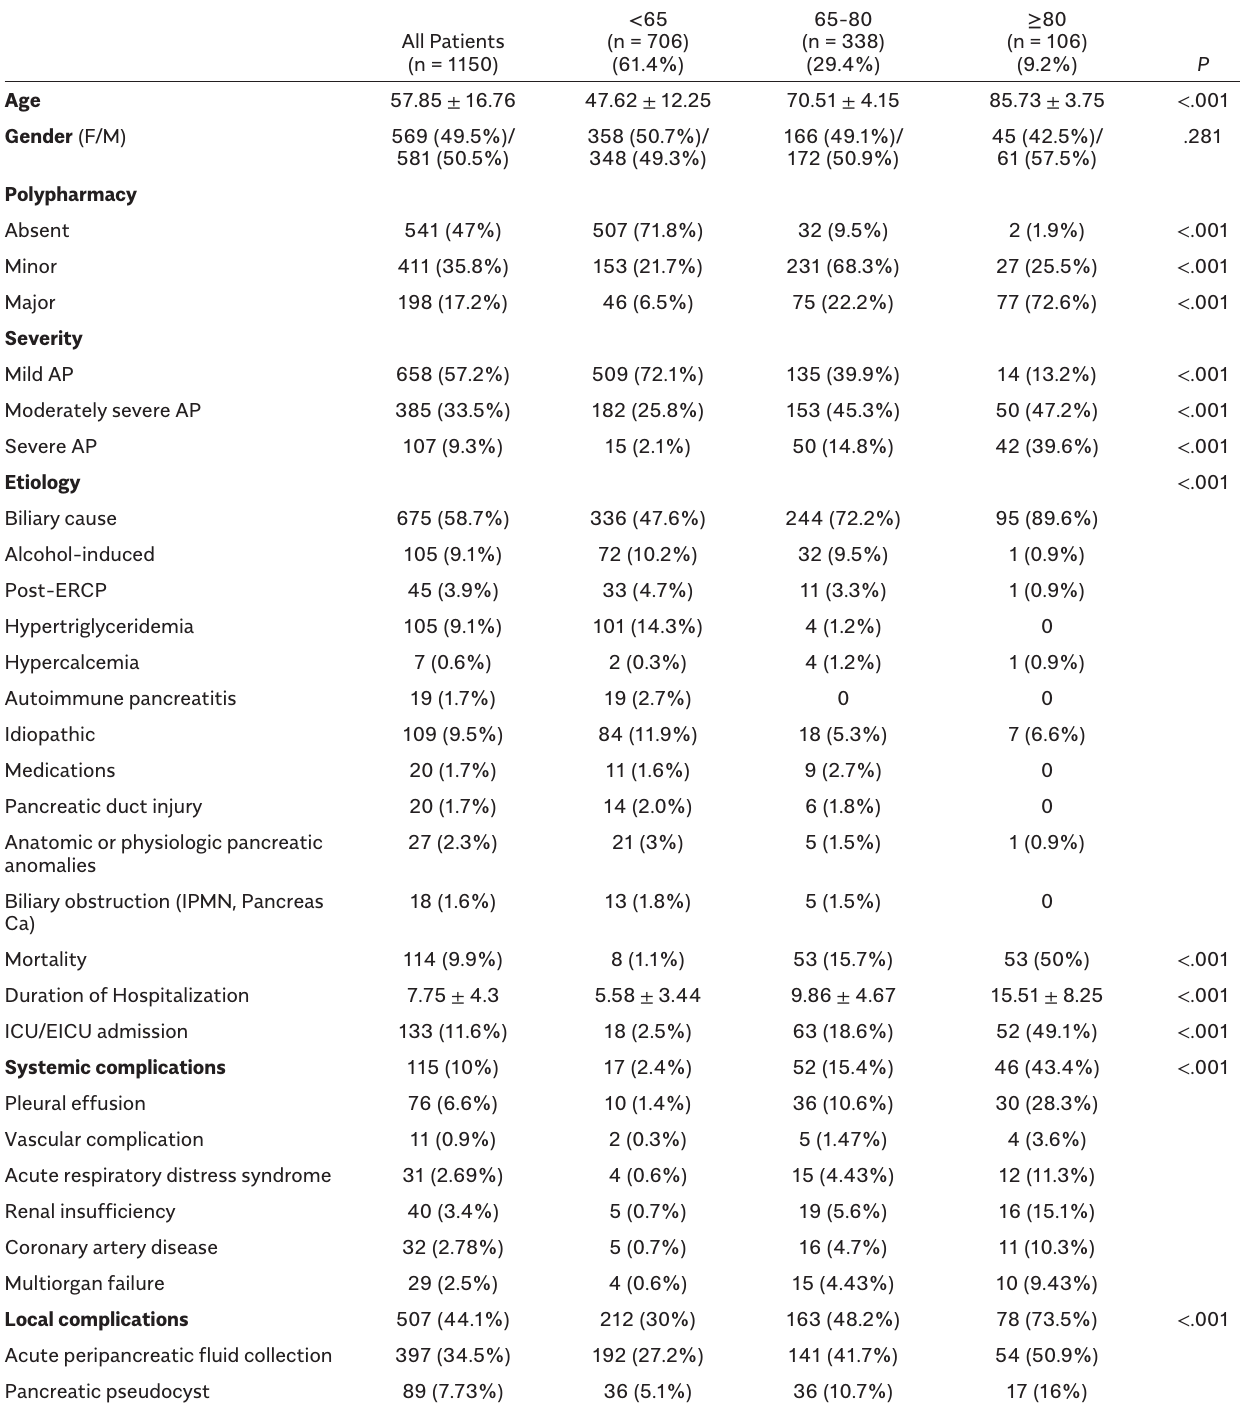
Table 1. Demographic, Clinical Characteristics, and Investigated Laboratory Parameters and Results of Scoring Systems in Patients Aged Over 65 Years and 80